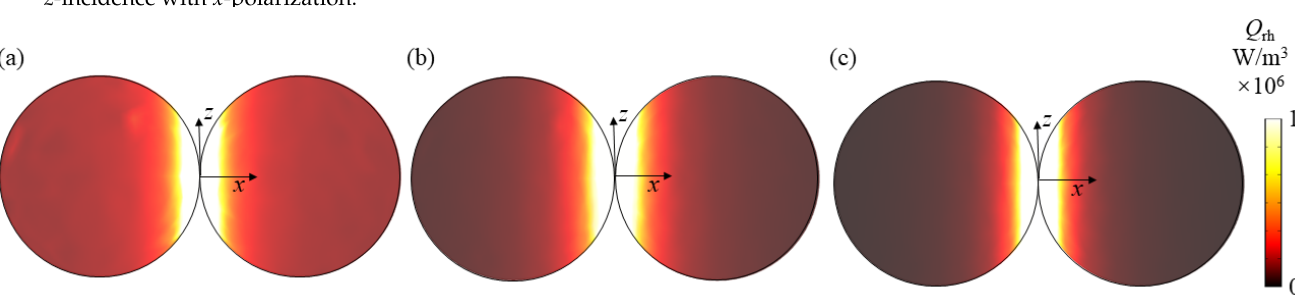
Figure 4. The electric/magnetic field distribution of dimer at ( a , b ) λ = 430 nm, ( c , d ) λ = 490 nm and ( e , f ) λ = 680 nm for z -incidence with x -polarization.